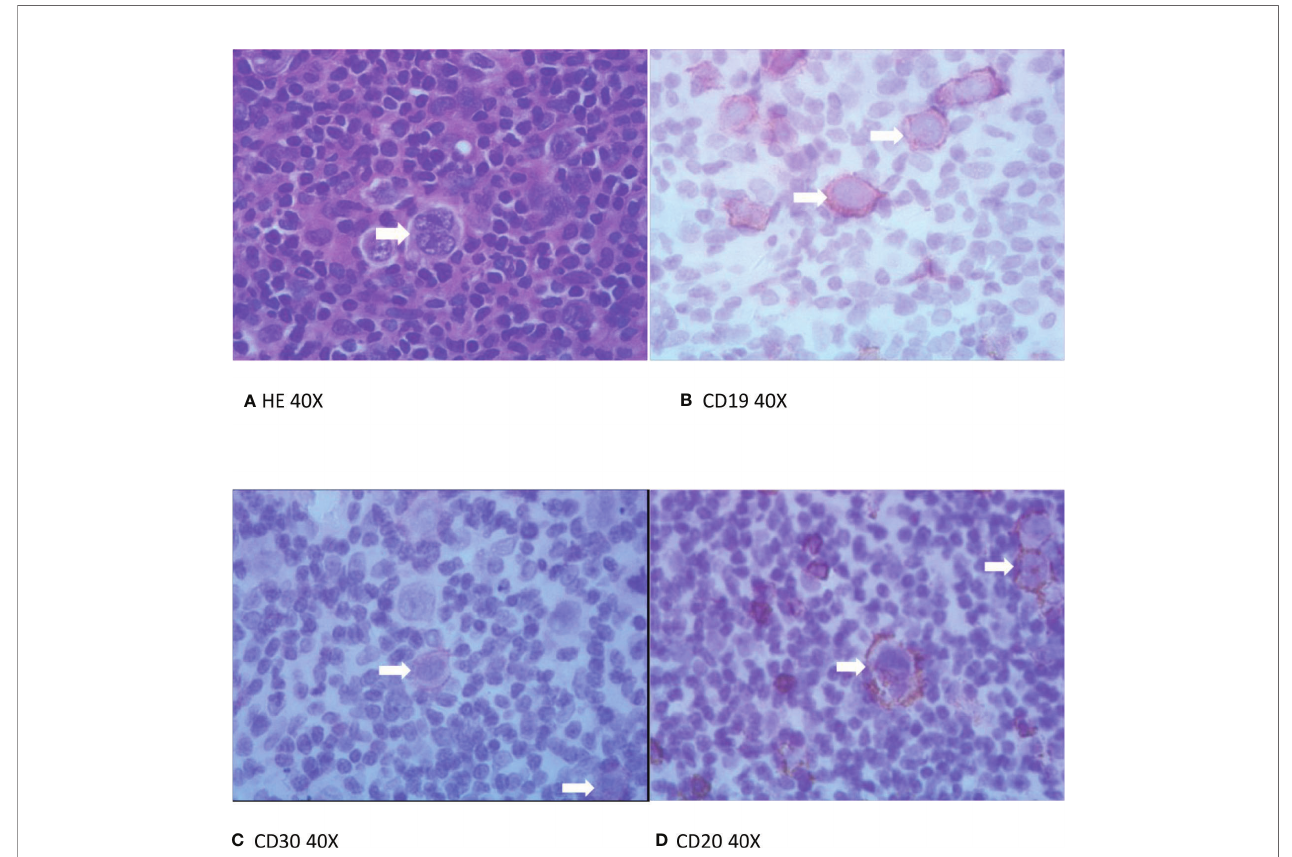
FIGURE 1 | Hematoxylin and Eosin staining (H&E) and immunohistochemical (IHC) staining of paraf fi n specimens. (A) H&E, staining in Reed-Sternberg cells (arrows). (B – D) of CD19, CD30, and CD20 IHC staining, respectively, in Reed-Sternberg cell